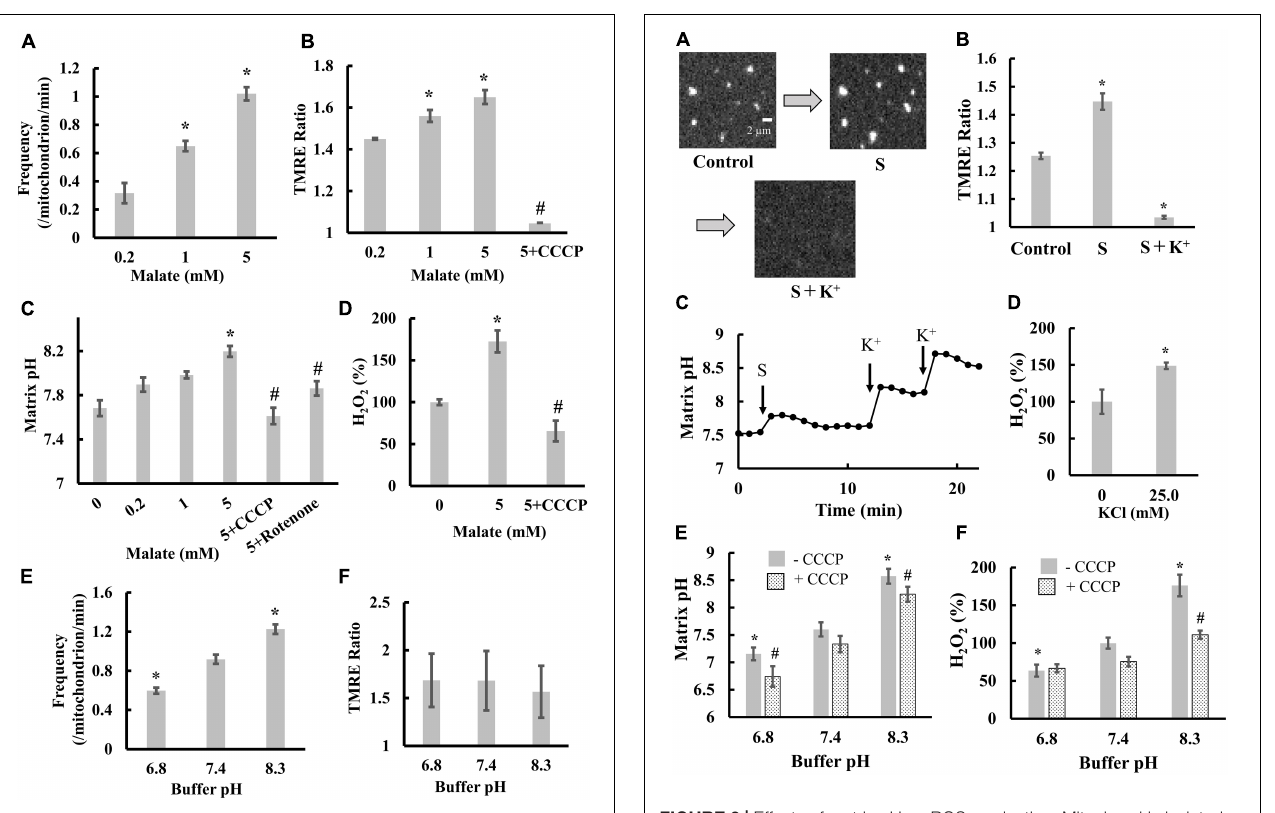
FIGURE 2 | Correlation among transient depolarization, (cid:49) ψ m , matrix pH, and ROS production in isolated mitochondria. (A) Effects of malate on the frequencies of transient depolarization. The frequency of depolarizations of the inner membrane is shown as the number of depolarizations/min/mitochondria. (B) The dependence of (cid:49) ψ m on malate and CCCP. The TMRE ratio was measured in individual mitochondria 1 min after the addition of malate. (C) Dependence of matrix pH on malate, CCCP, and rotenone. Matrix pH was measured in individual mitochondria 1 min after the addition of malate. (D) Effects of malate and CCCP on ROS production. H 2 O 2 production in mitochondria without adding malate was set at 100%. (E) Effects of buffer pH on the frequencies of transient depolarization in the presence of 5 mM malate. (F) Dependence of (cid:49) ψ m on buffer pH. TMRE ratios for individual mitochondria were measured 1 min after the addition of 5 mM malate. Values represent the mean ± SEM ( n > 50 for A–C,E,F ; n = 3 for D ). * p < 0.05 vs. 0.2 mM for (A,B) ; vs. 0 mM for (C,D) ; pH 7.4 for (E) . # p < 0.05 vs. 5 mM for (B,C,D) .